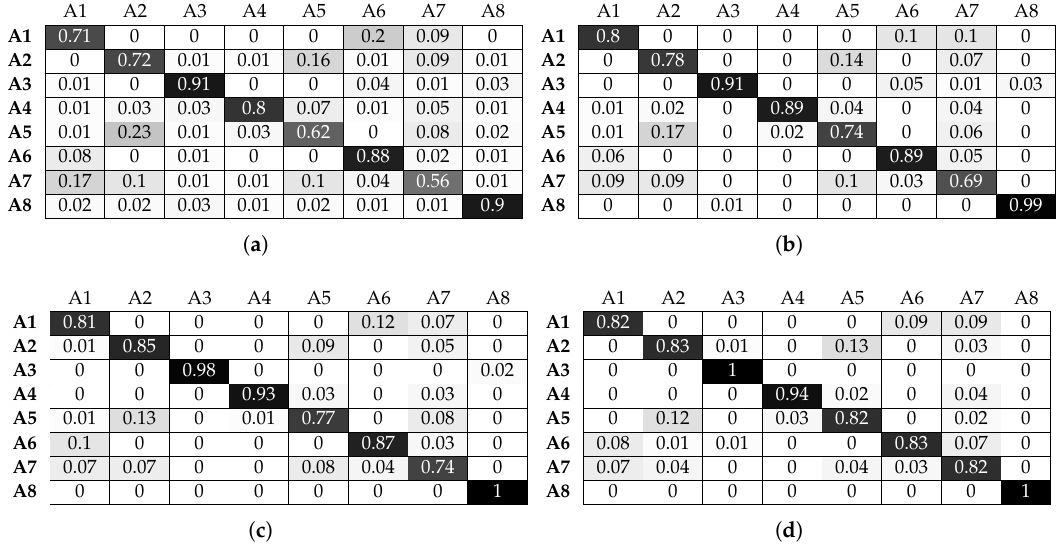
Figure 11. Normalised confusion matrices for logistic regression, with Wearable Feature Type 2, with beacon data. ( a ) C = 10, w = 1 s; ( b ) C = 10, w = 2 s ; ( c ) C = 10, w = 3 s; ( d ) C = 100, w = 4 s.